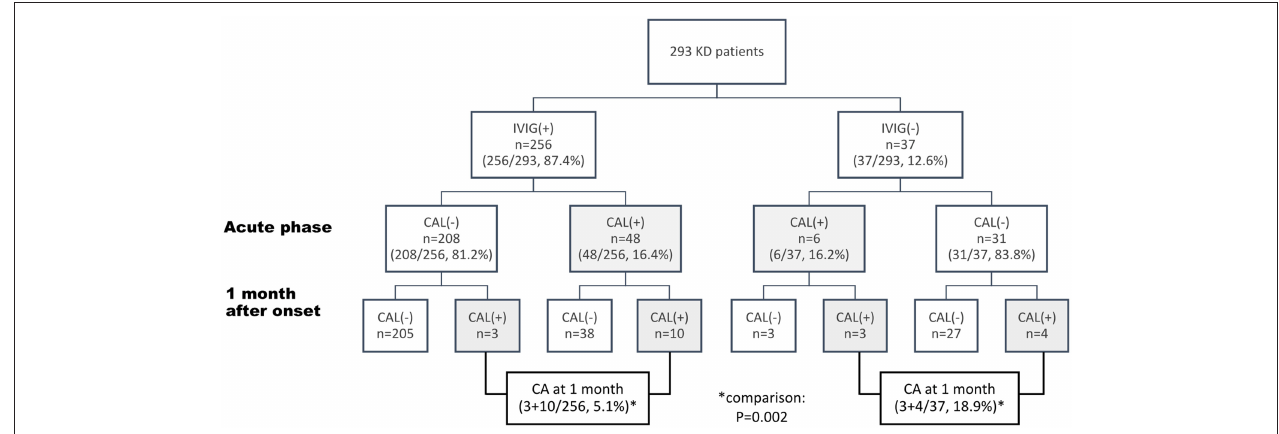
FIGURE 1 | Flow chart of management and coronary outcome of 293 patients with Kawasaki disease (KD) The data are expressed as case numbers (percentage of total patients). IVIG, intravenous immunoglobulin; CAL, coronary artery lesion, defined as Z score of coronary diameters ≥ + 2.5.